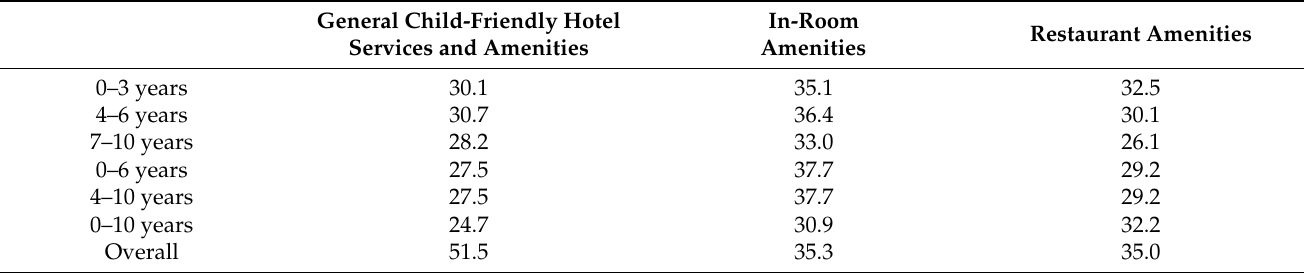
Table 4. The degree (expressed as a percentage) to which a hotel offer meets the expectations of parents with children of different